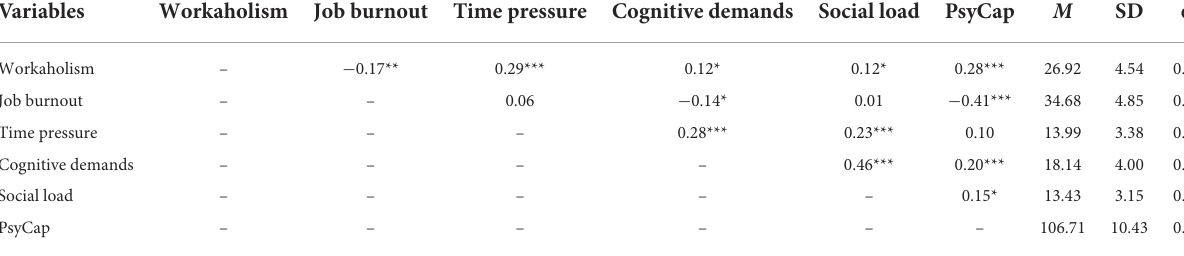
TABLE 1 Correlation matrix, psychometric properties and descriptive statistics of the scales used in the study. Variables